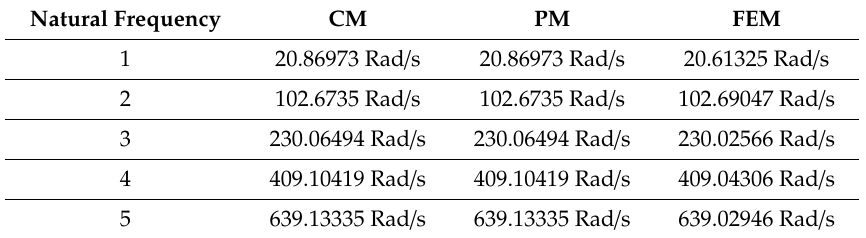
Table 3. Comparison of natural modes, 3 span